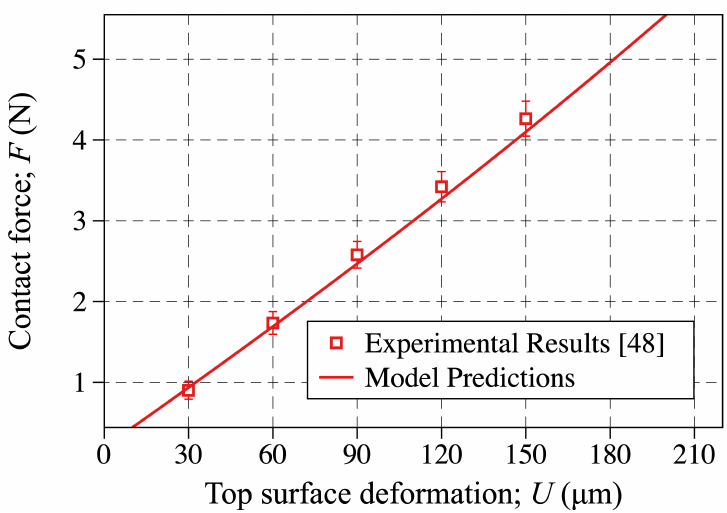
Figure 10. The probe contact force plotted against the top surface deformation level. The discrete points are showing the experimental result reported in [48], whereas the solid line is showing the modeling results obtained through Equation